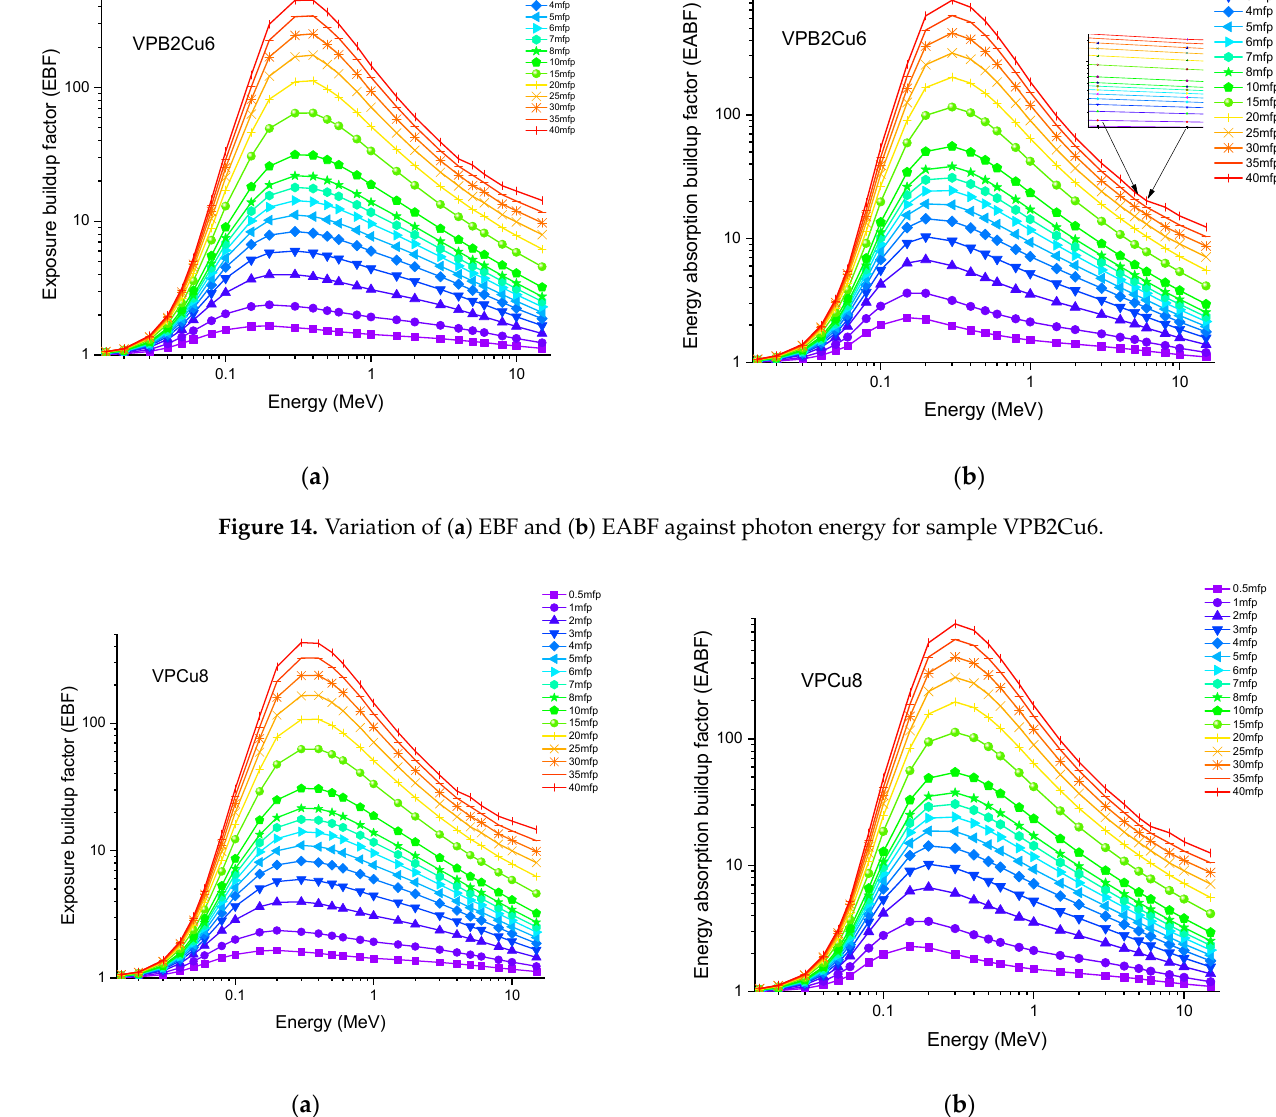
Figure 15. Variation of ( a ) EBF and ( b ) EABF against photon energy for sample VPCu8. Finally, Figure 16 depicts the variation in effective conductivity (C eff ) for all glass samples at 300K (s/m). The effective conductivity C eff (s/m) values of the examined glass samples were obtained in the photon energy range of 0.015–15 MeV. The effective conductivity C eff (s/m) of a shielding-material for attenuation at room temperature (300 K) is proportional to the effective number of electrons per gram. As observed in Figure 16, C eff has an inverse relationship with photon energy, that is, as the energy increases, C eff values decrease rapidly, especially in the region where photoelectric interactions are dominant [27]. Furthermore, the sample with the highest CuO content (VPCu8) has the highest C eff values at all photon energies.